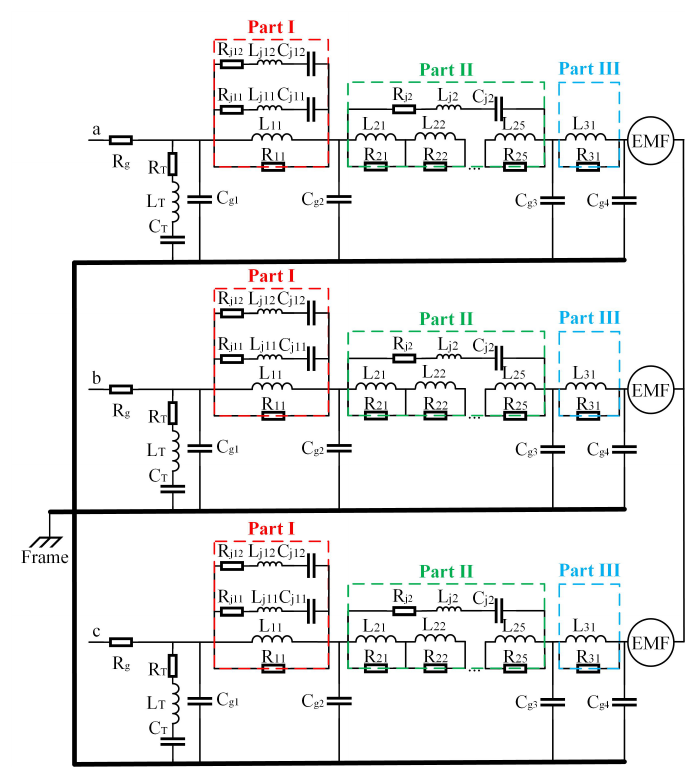
Figure 6. HF circuit model of the three-phase motor with star connection.